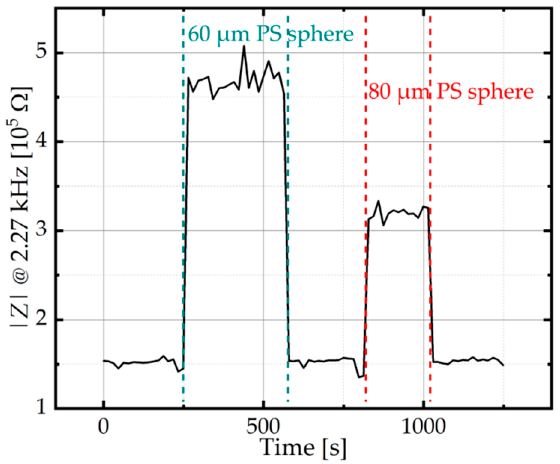
Figure 6. Time dependency of the impedance magnitude at 2.27 kHz during trapping and release of single polystyrene (PS) spheres (60 µm and 80 µm in diameter) in 1 mM PBS, respectively.